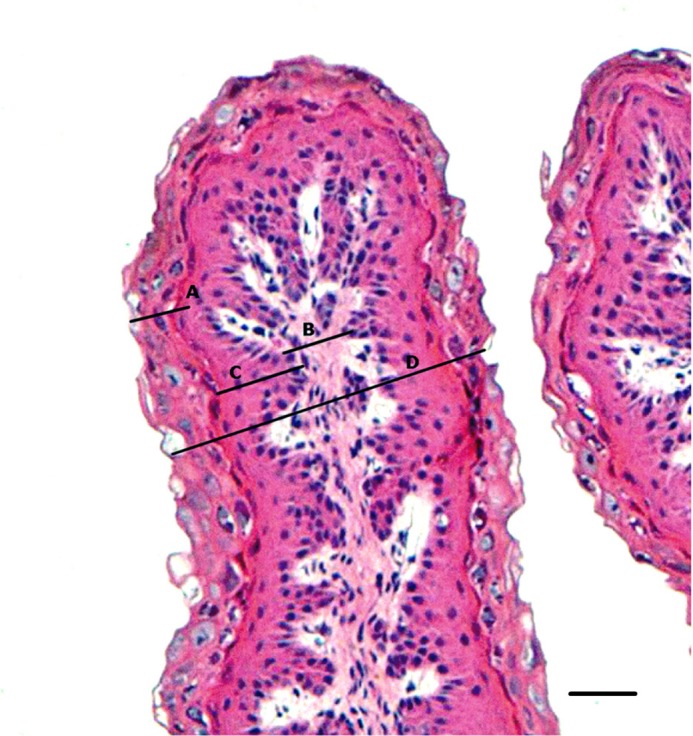
Histology of ruminal papillae of sheep fed grain-based diets stained by hematoxylin-eosin method using the 10x objective.(A) Stratum corneum thickness (B) Connective tissue width. (C) Non-keratinized epithelium (D) Total epithelium thickness.